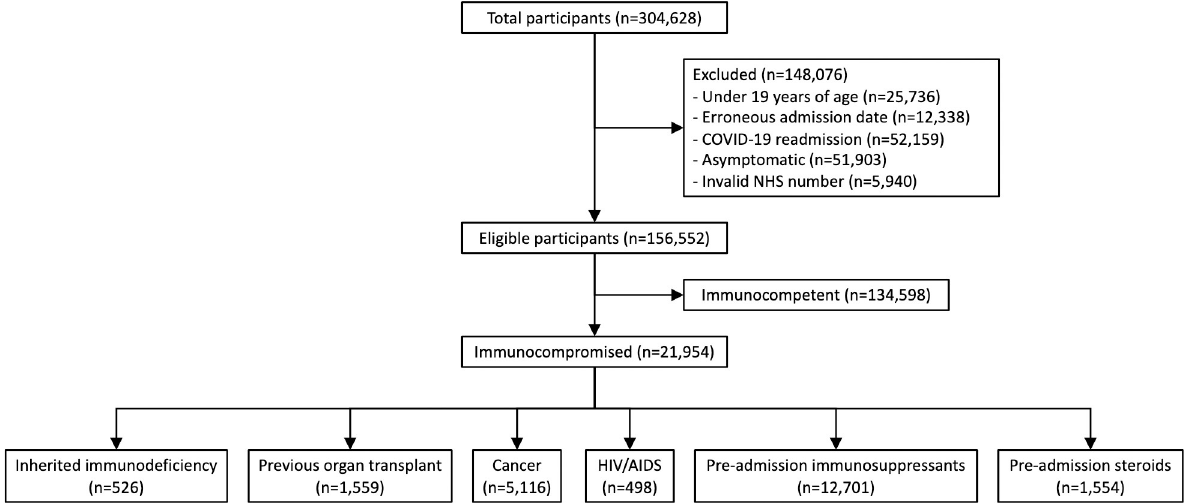
Fig 1. Flow diagram of patients in the study. The total number of participants entered into the ISARIC CCP-UK database, reasons for exclusion, and numbers of patients in each category of immunocompromise are shown. CCP-UK, Clinical Characterisation Protocol in the United Kingdom; COVID-19, Coronavirus Disease 2019; ISARIC, International Severe Acute Respiratory and emerging Infection Consortium.